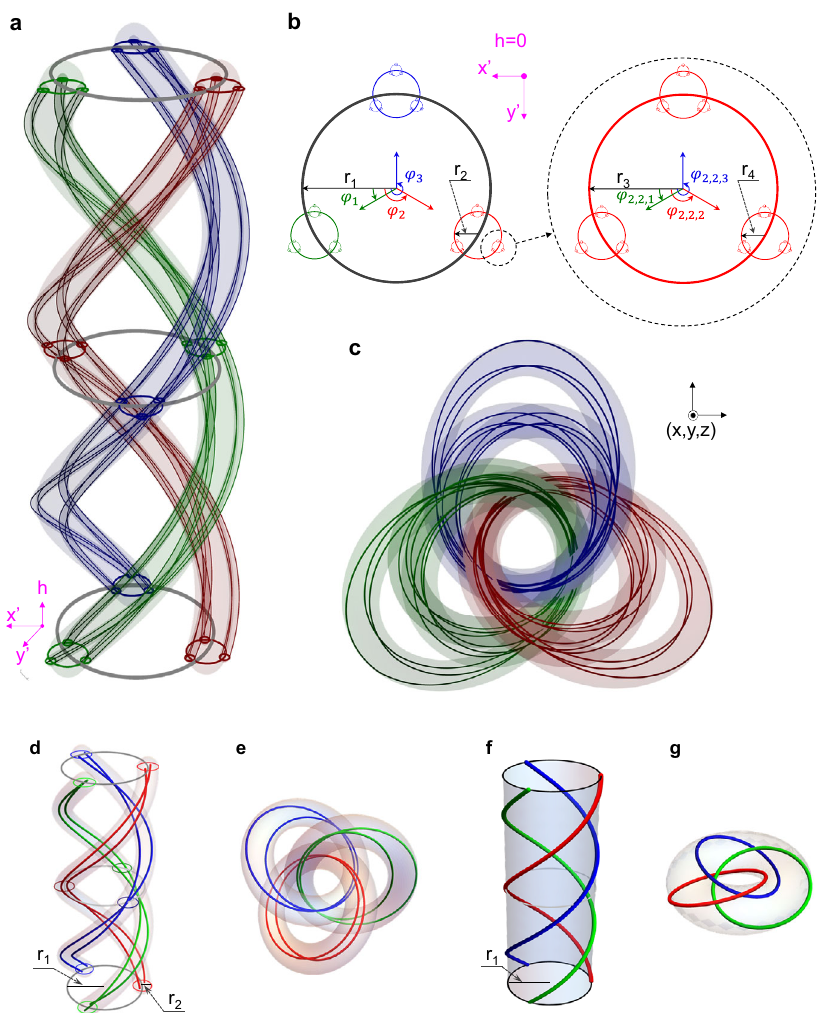
, φ , and φ ( φ , φ , and φ ), respectively. 1 2 3 2 ; 2 ; 1 2 ; 2 ; 2 2 ; 2 ; 3